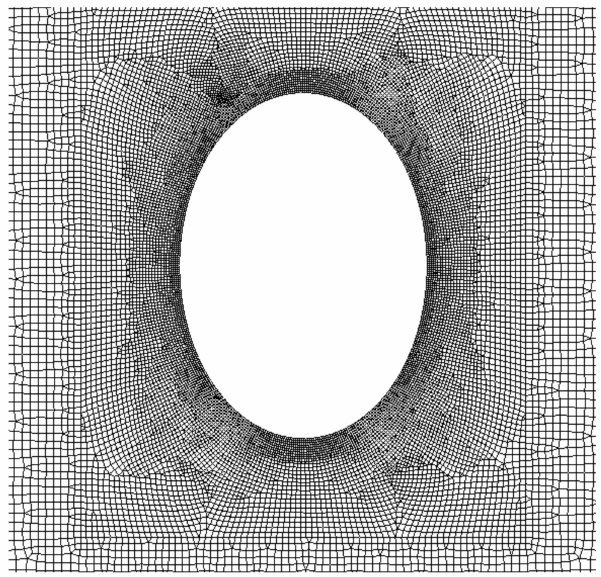
Figure 8. Detailed demonstration of the computational grid within the rigid